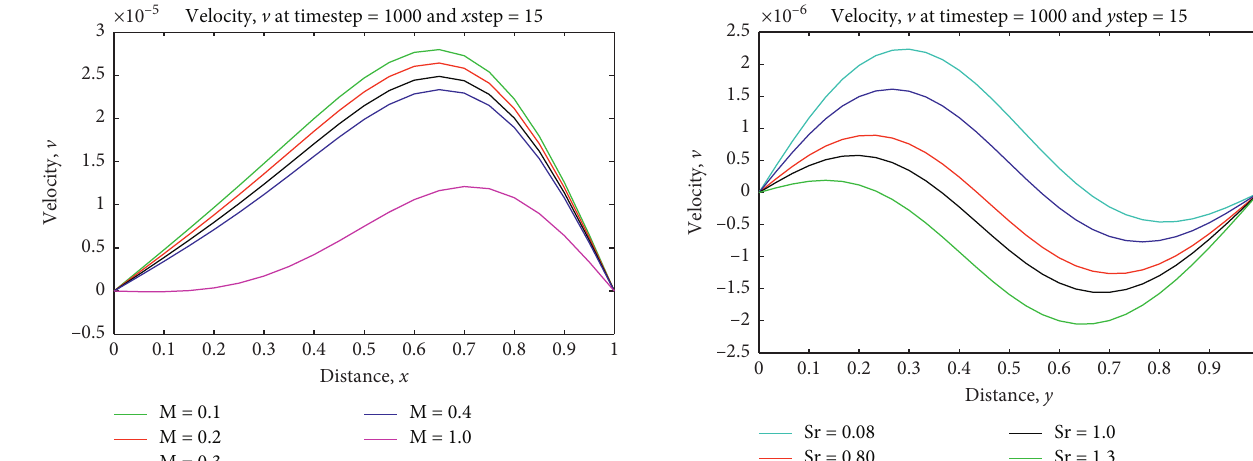
Figure 8: Effects of magnetic parameter on secondary velocity